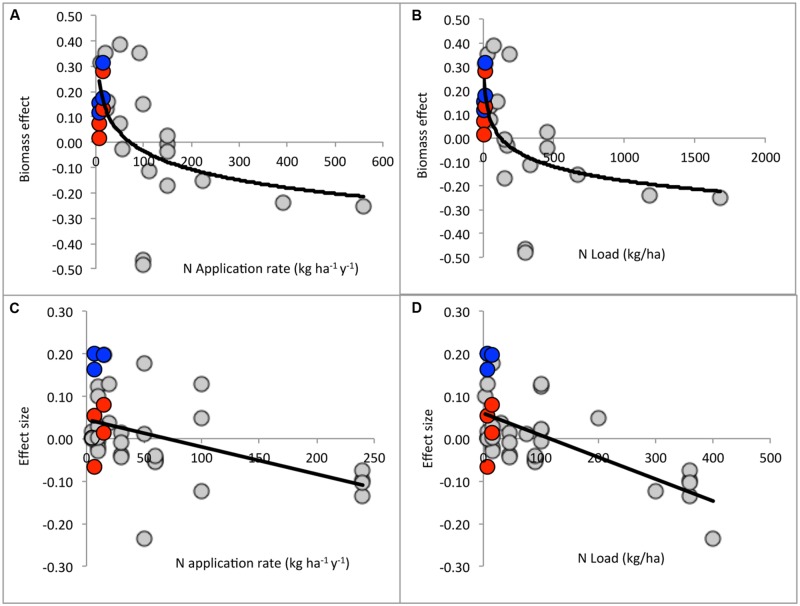
Meta-analysis of aridland microbial responses to N addition. (A) Microbial biomass in relation to N application rate: effect = -0.0959 (ln rate) + 0.429 (r2 = 0.358, n = 26, p = 0.00125). (B) Microbial biomass in relation to cumulative N load: effect = -0.0779 (ln load) + 0.395 (r2 = 0.386, n = 26, p = 0.0007). (C) Metabolic rates in relation to N application rate: effect = -0.00065 (rate) + 0.455 (r2 = 0.21, n = 41, p = 0.0024). (D) Metabolic rates in relation to cumulative N load: effect = -0.00052 (load) + 0.0593 (r2 = 0.41, n = 41, p < 0.00001). Blue circles represent Lake Mead bulk soil responses. Red circles represent Lake Mead biocrust responses. Data from Supplementary Table S1.